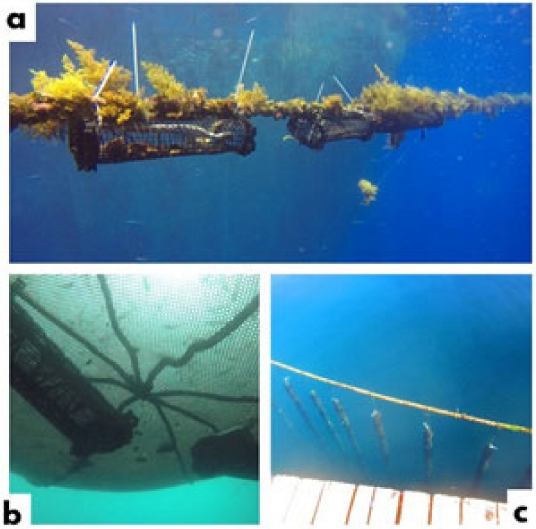
Figure 2. IMTA: Co-culture of sea bream, European sea bass, Mediterranean mussel, pearl oyster, and sea cucumber: ( a ) figure of pearl oysters cultivated in SEAPA© baskets, submerged next to the fish cages at 3 m depth; ( b ) figure of SEAPA baskets with sea cucumbers submerged under a fish cage; ( c ) figure of mussels in elongated plastic cylindrical tubing nets (pergolaris), a traditional mussel cultivating